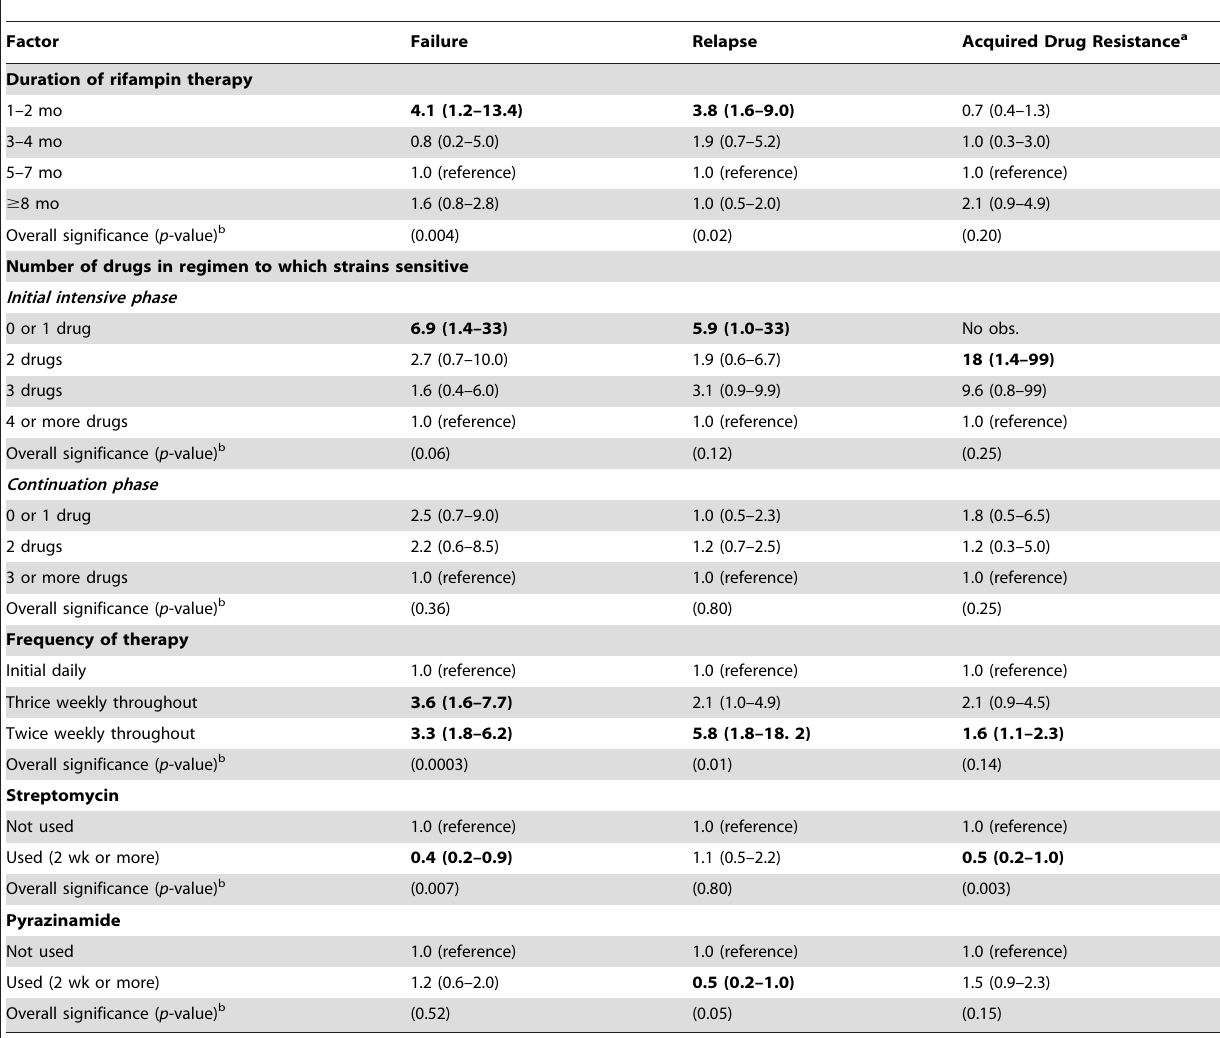
Table 6. Adjusted incidence rate ratios of failure, relapse, and acquired drug resistance in INH resistant